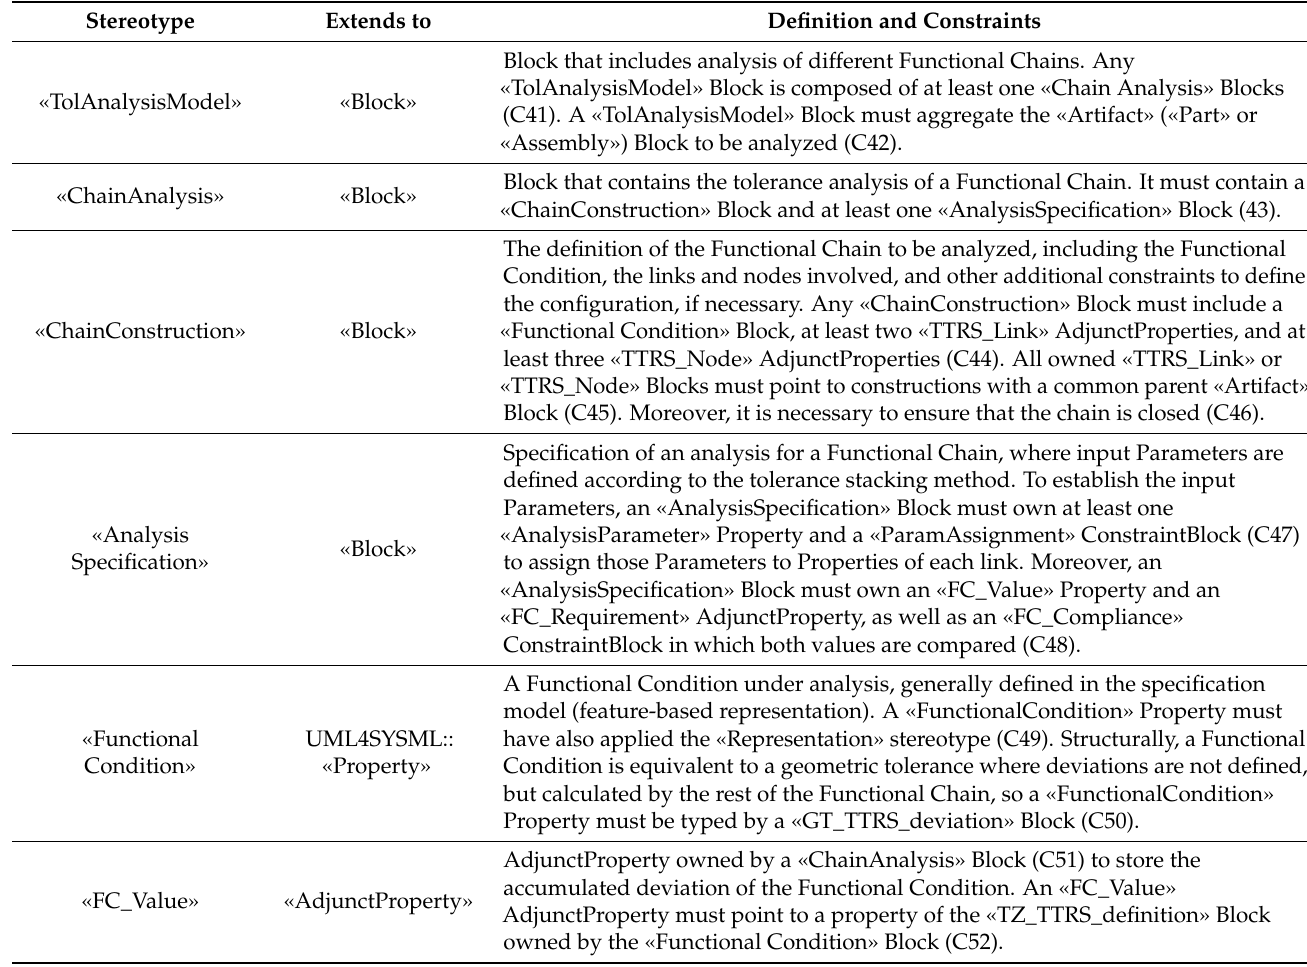
Table A4. Description of main TAPP